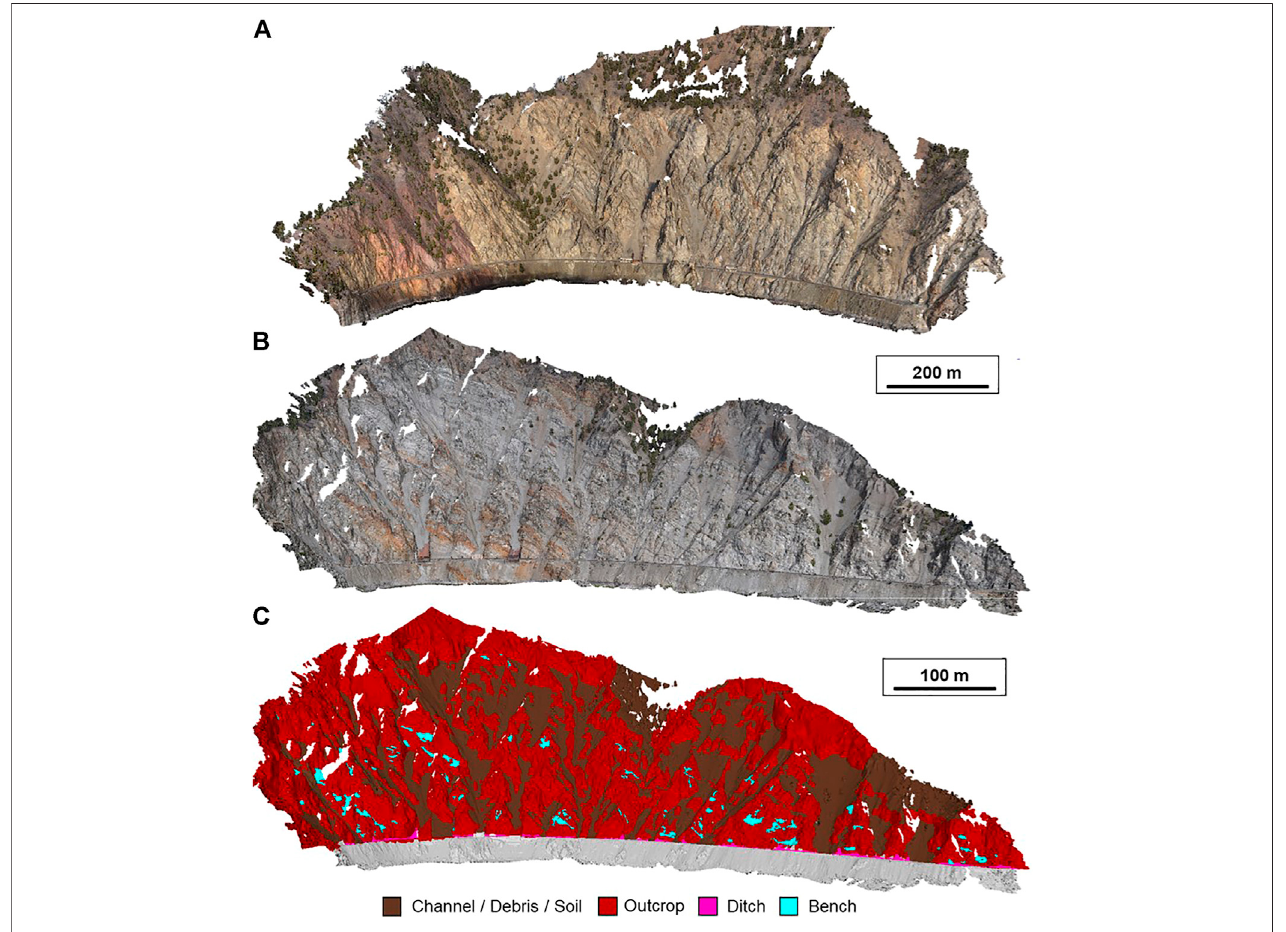
FIGURE 5 | Overview of the SfM-MVS photogrammetry models. (A) Model of WCW from photographs taken on 30 January 2017. (B) Model of WCE from photographstakenon4April2017. (C) Classi fi edmodelofWCE.ThemodelwasremotelymappedinPhotoScanusingacombinationoftheRGBpointcloudandvisual inspection of the panoramic photography. Figure from Bonneau et al.